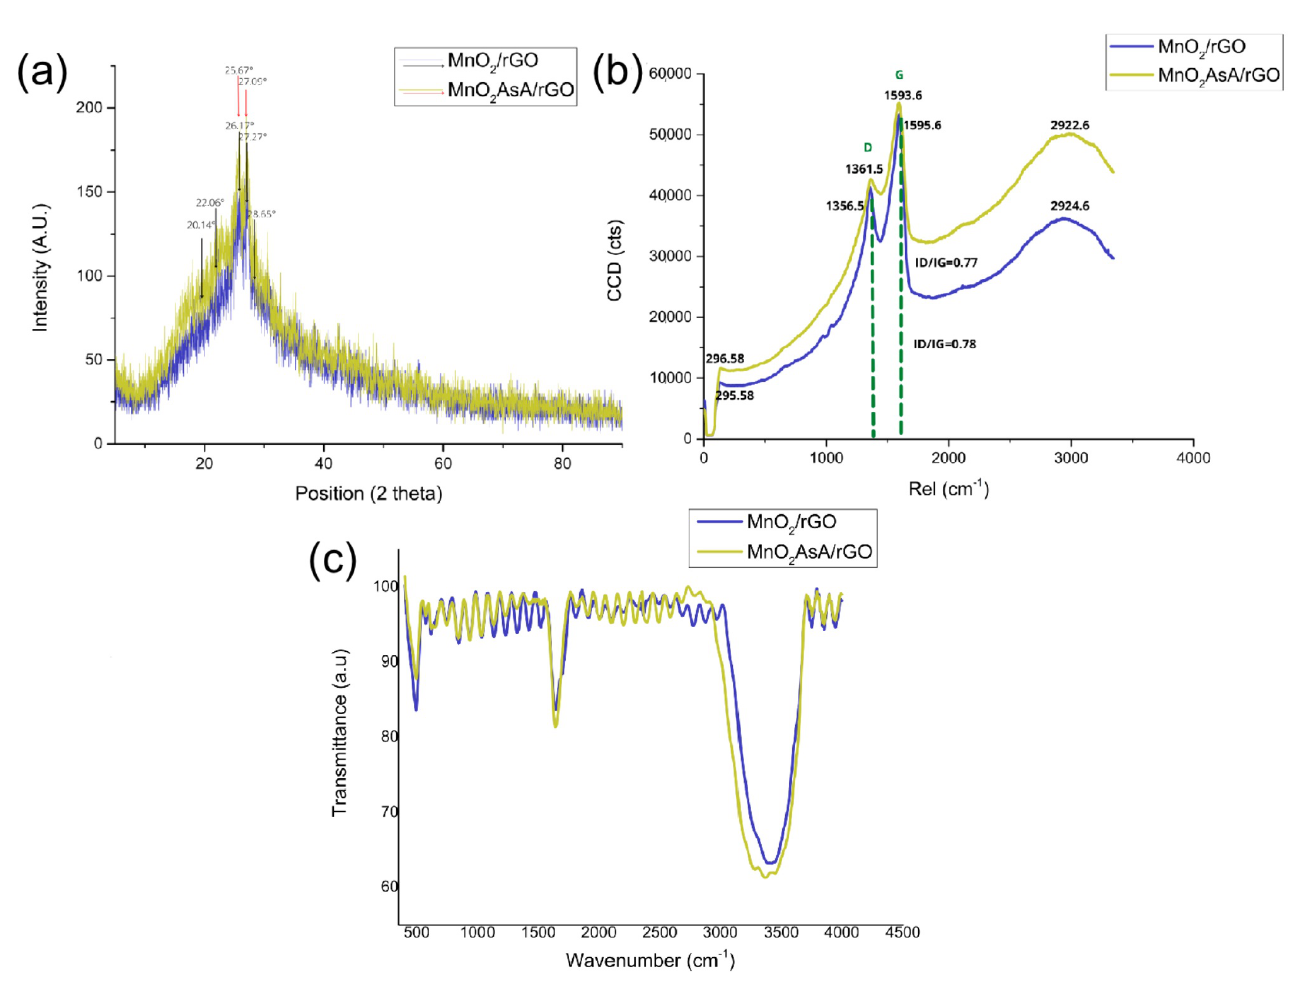
Figure 6. ( a ) XRD analysis of the nanocomposites MnO 2 /rGO and MnO 2 AsA/rGO, ( b ) Raman spectroscopy of MnO 2 /rGO and MnO 2 AsA/rGO nanocomposite particles and ( c ) FTIR spectra of MnO 2 /rGO and MnO 2 AsA/rGO